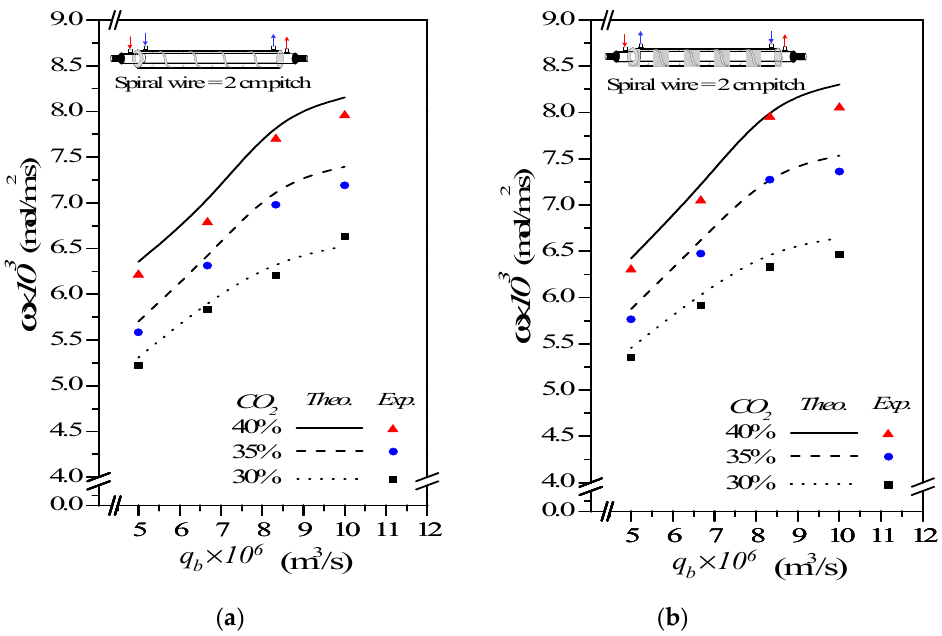
Figure 10. Effects of MEA flow rate and inlet CO 2 feed concentration on CO 2 absorption flux. ( a ) Concurrent-flow operations; ( b ) Countercurrent-flow operations.